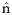
Schematic representation of relevant cell polarization events during budding yeast mating projection growth.A, Transmitted light image of a S. cerevisiae cell growing a mating projection in the presence of α-factor. Scale bar, 2μm. b-e, Sketch of molecular events leading to the polarization of the cell during the growth of the mating projection. B, Cdc42 polarizes and recruits Bni1. C, Bni1, a formin, nucleates actin filaments. D, Membrane vesicles travel along actin cables bringing in Cdc42. E, The CWI pathway couples the mechanics of the cell wall to Bni1 activation via Rho1. F, Geometrical representation of the system and definition of the relevant variables: s, arc length from the apex, ϕ azimuthal angle, r local cell width, θ angle between the local outward normal (n^) and the axis of growth (z) and h thickness of the cell wall. G, Sketch depicting the increasing cell wall viscosity and decreasing cell wall assembly away from the apex. The inset depicts local normal force balance at the cell wall. All variables are defined in the main text.